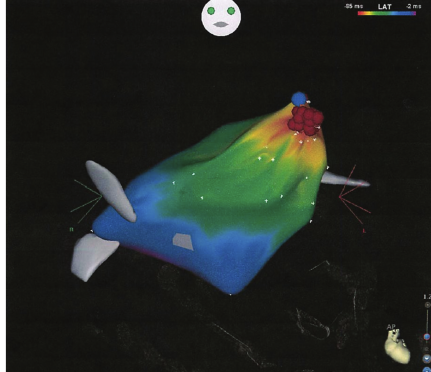
Figure 3: 3D activation map of left atrium in AP